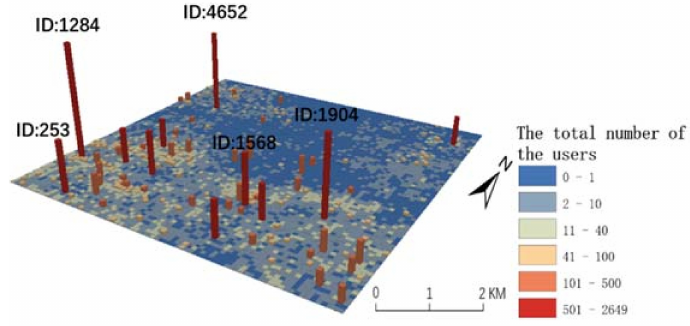
Figure 4. Grid transformation of the total number of Sina users in June 2014. Grid IDs are provided for the five grids with the highest numbers of